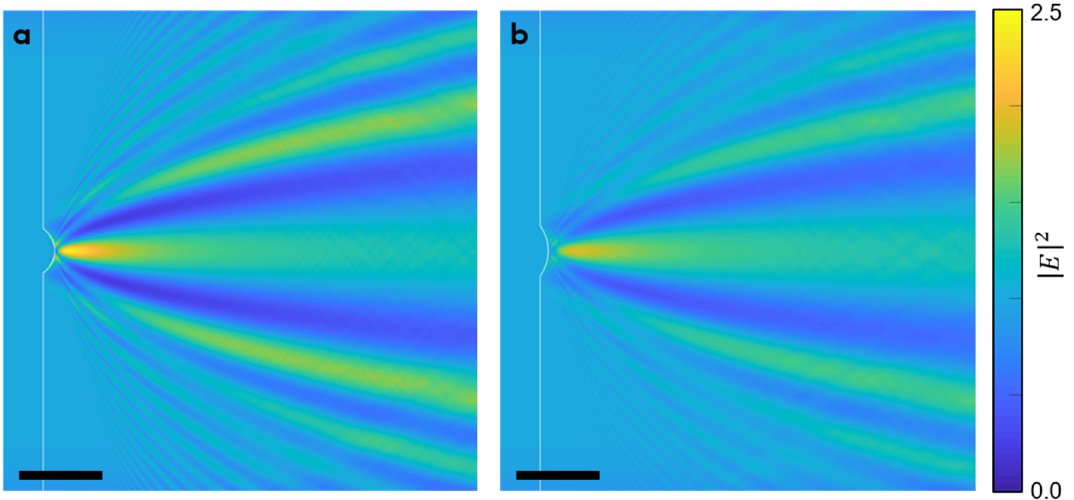
Figure A2. BPM simulation results of plane wave focusing caused by nanolenses fabricated with a UV dose of ( a ) 0.0 J/cm 2 and ( b ) 1.9 J/cm 2 . The output patterns are distinctly different in their near ‐ and far ‐ field characteristics (scale bars: 1 μ m).